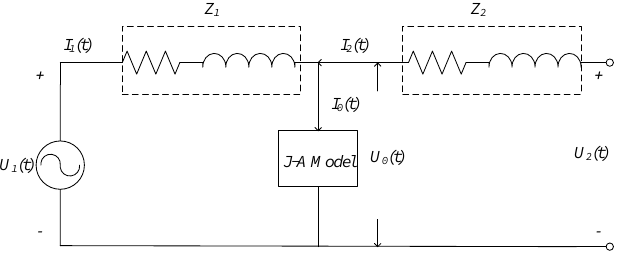
Figure 2. Equivalent circuit